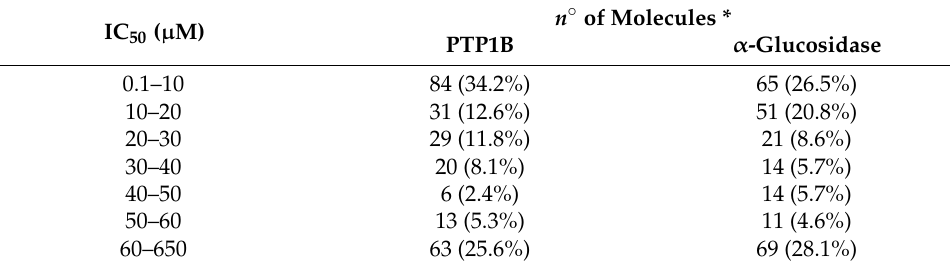
Figure 5. Distribution of the IC 50 values calculated for both PTP1B ( left ) and α -glucosidase ( right ). The IC 50 values are categorized as shown in Table 13. Table 13. Distribution frequency of IC 50 values for PTP1B and α